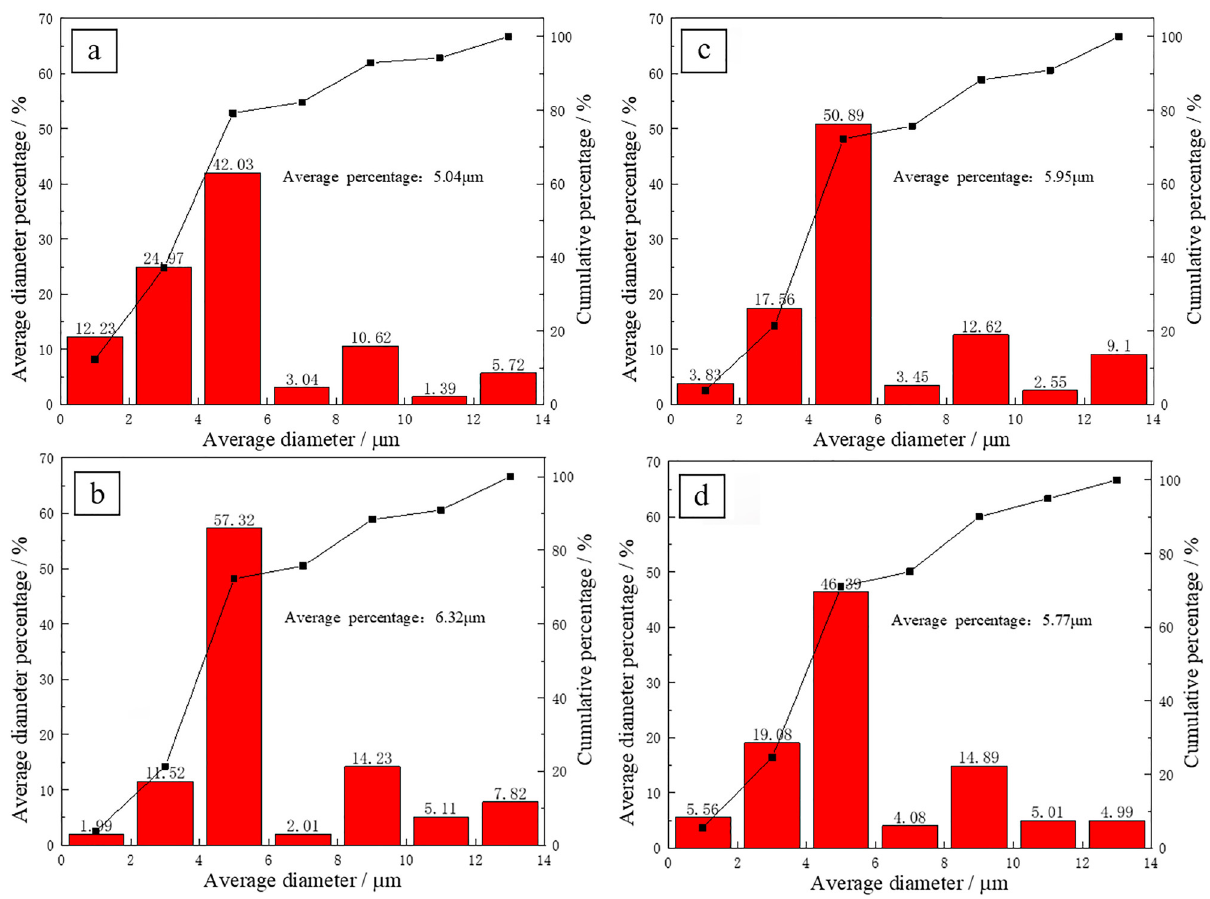
Figure 6: Distribution of the phases containing W in the CuW composites prepared with di ff erent R ( C/A ) ( a: 0, b: 0.2, c: 0.6, and d: 1.0 )